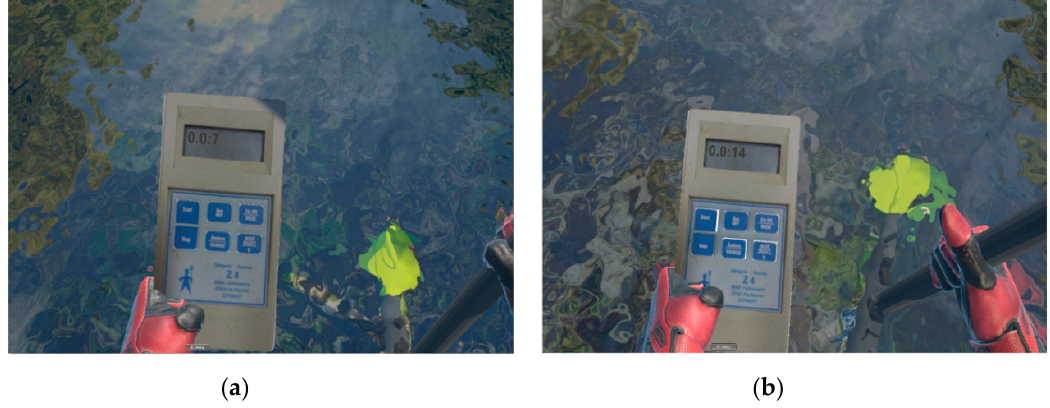
Figure 8. Handheld keypad with ( a ) flat buttons and ( b ) lifted buttons.